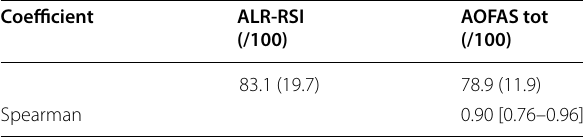
Table 4 Correlation between ALR‑RSI and AOFAS Coefficient